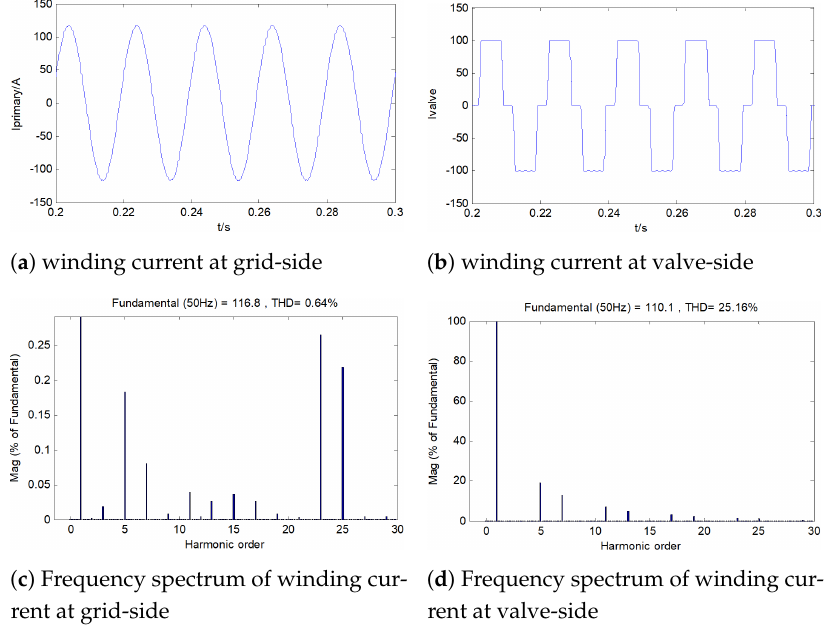
Figure 8. Waveformand frequency spectrum of the winding current from the valve-side and grid-side on the left column of the converter transformer under working condition 3.